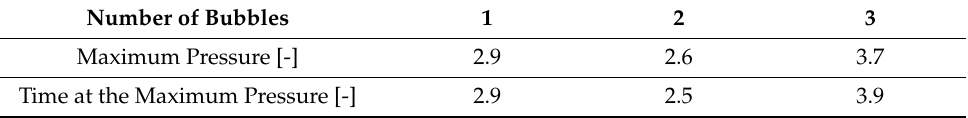
Table 5. Comparison of the maximum pressure values and maximum pressure arrival times. Number of Bubbles